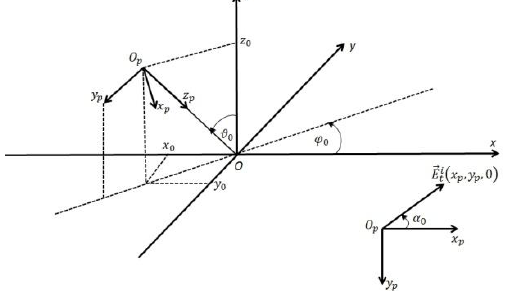
Figure 2: The coordinate